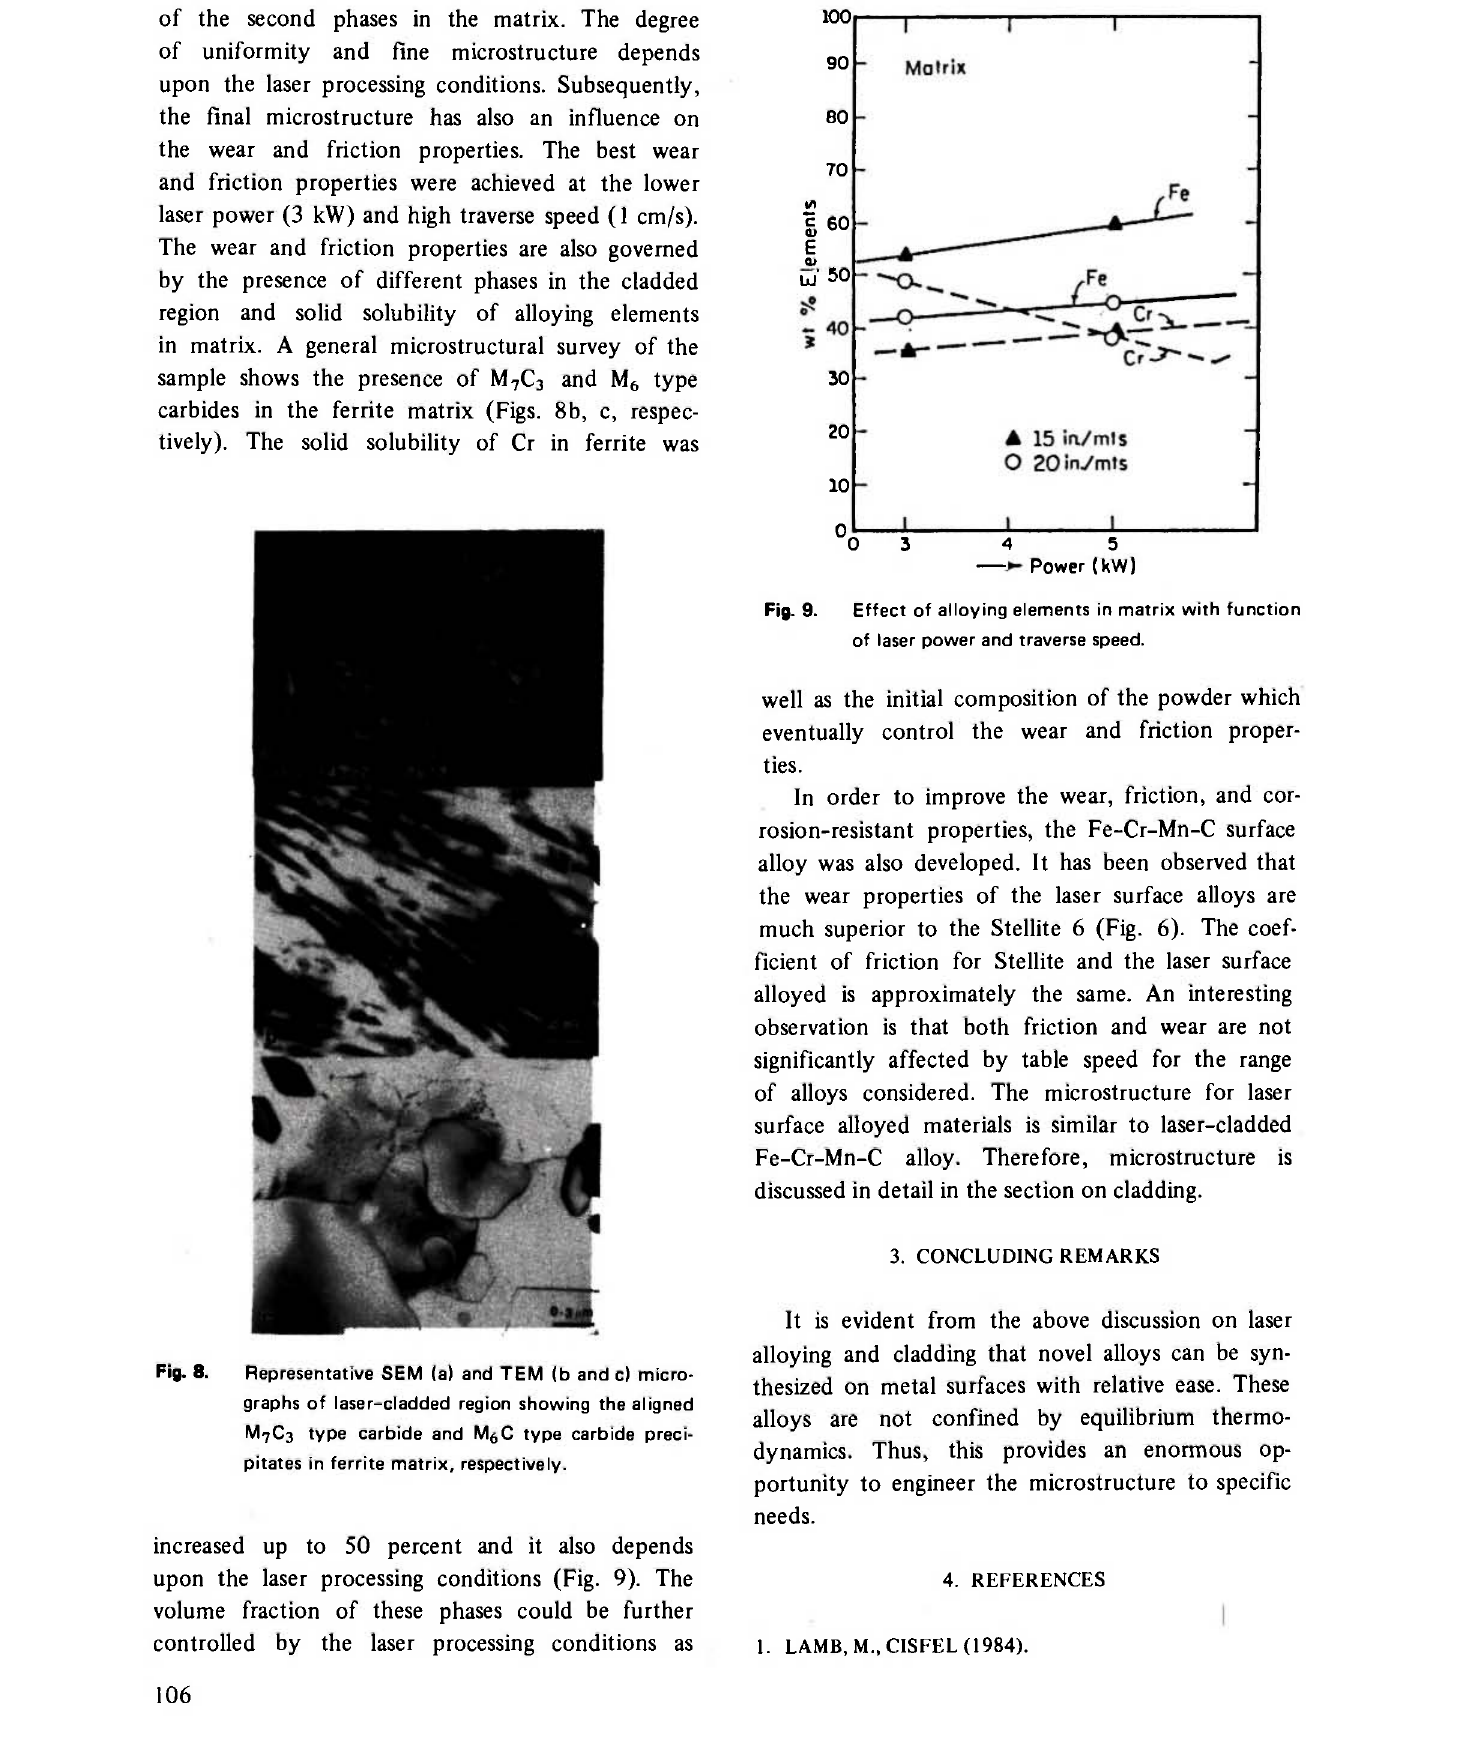
Fig. 8. Representative SEM (a) and TEM (b and c) micro- graphs of laser-cladded region showing the aligned M7C3 type carbide and M^C type carbide preci- pitates in ferrite matrix, respectively.